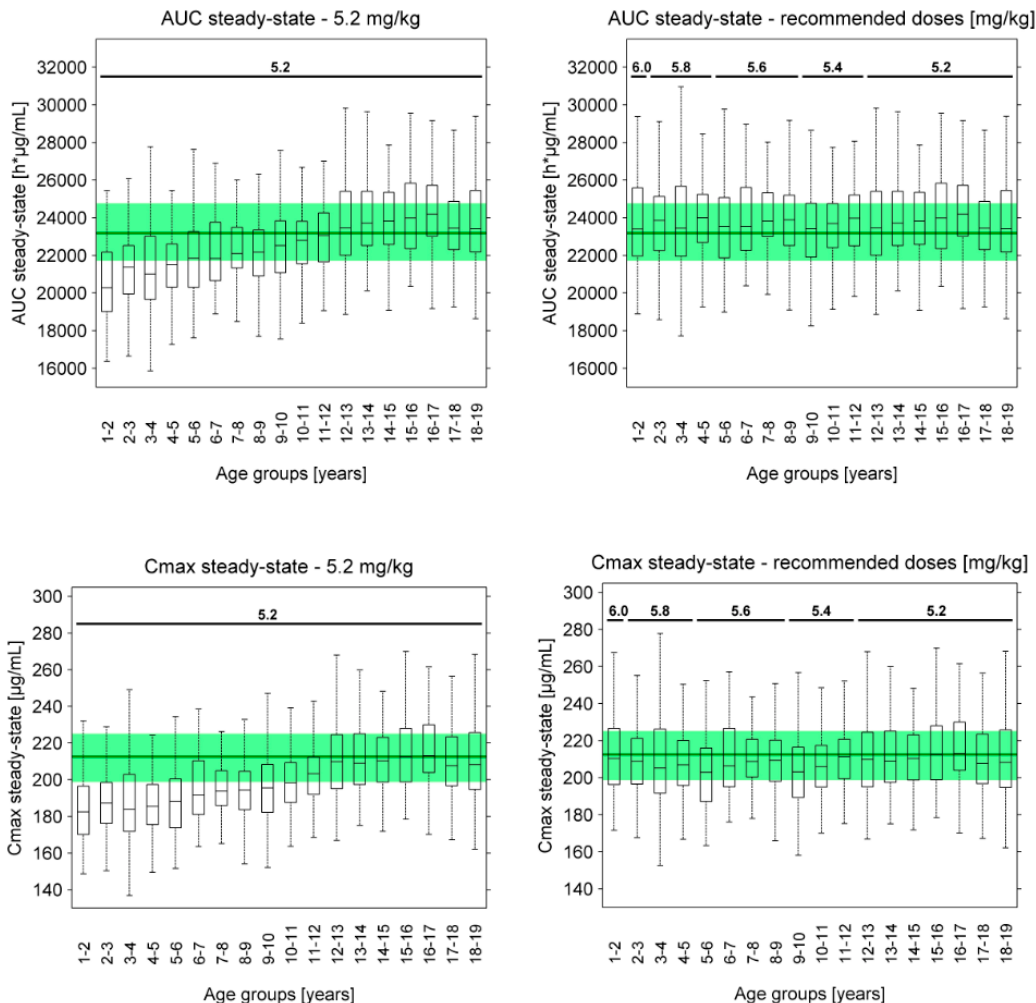
Figure 7. Population predicted asunercept steady-state (week 15) AUC and C max values following administration of 5.2 mg/kg asunercept QW ( left panel ) or of the recommended doses ( right panel ) to children of different age groups. The boxes show population medians, 25th and 75th percentiles, the whiskers represent the most extreme data points not considered outliers. The dark green lines and shaded green areas illustrate the median and 25th to 75th percentile interval of the adult reference population of the Phase II study APG101_CD_002. Simulations were conducted using a sialic acid:glycan ratio of 0.64 for asunercept. Table 4. Asunercept dose recommendations for pediatric patients.